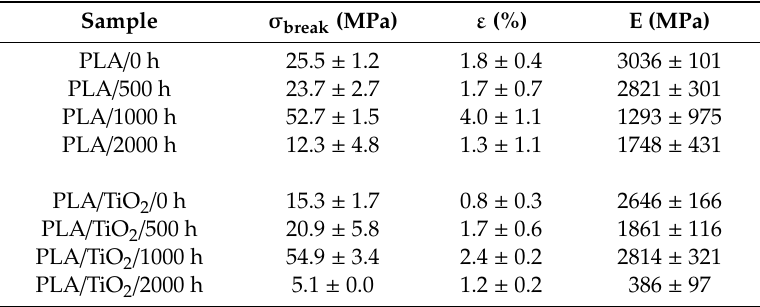
Table 5. Mechanical properties of neat PLA and the PLA / TiO 2 after di ff erent periods of accelerated